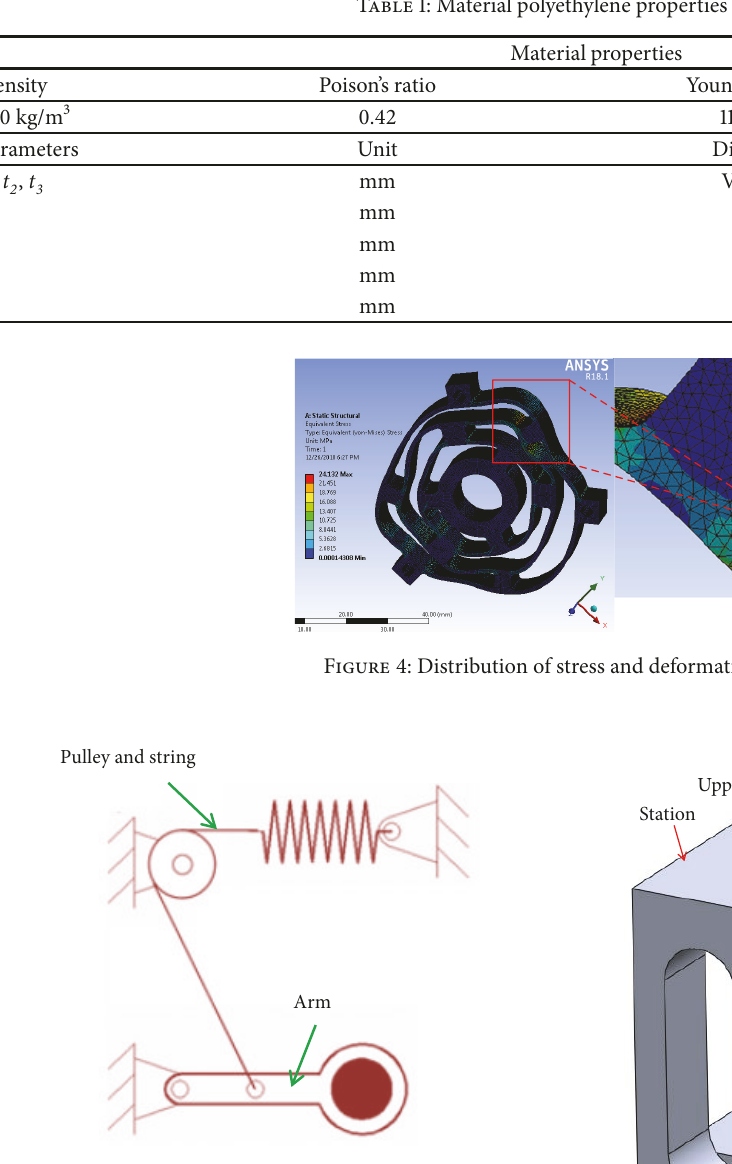
Figure 5: Conventional assistive device.